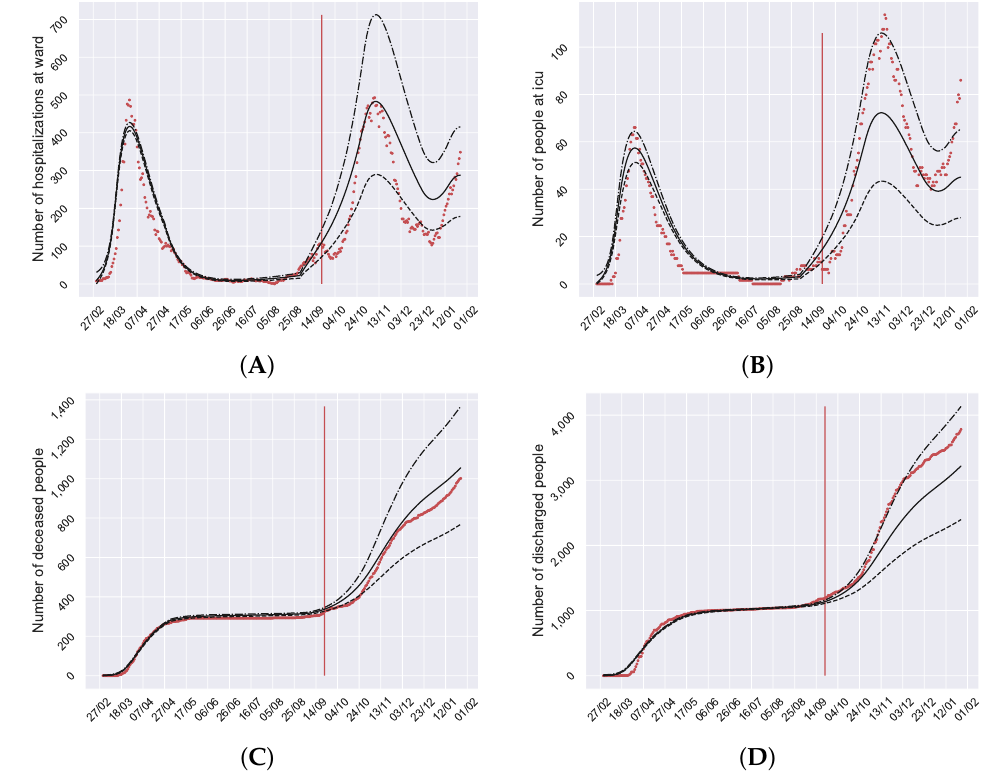
Figure 4. Model validation. ( A ) Number of daily hospitalized at ward people. ( B ) Number of daily people in ICU. ( C ) Number of accumulated deceased people. ( D ) Number of accumulated discharged people. The vertical red lines (23 September 2020) divide the calibration from the validation. The black bands are the mean and the CI95% of the model outputs. The red points are the data collected from the hospitals. The model captures most of the data red points after 23 September, predicting the evolution of the second and the third